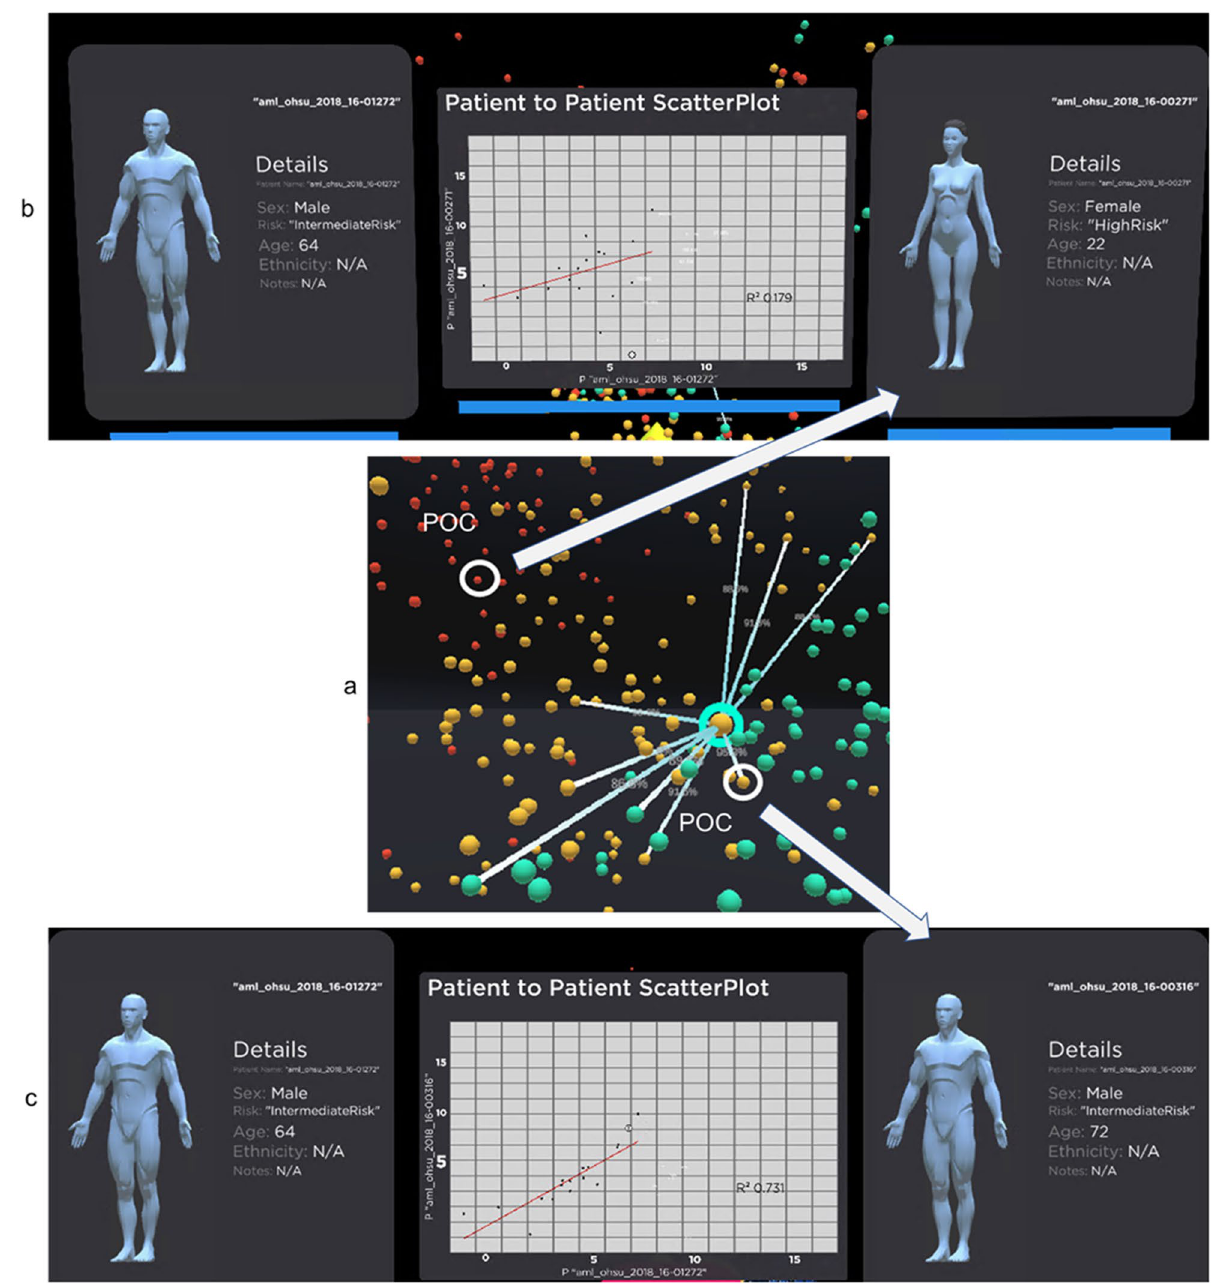
Figure 4. Patient-to-Patient Comparison panel. ( a ) The patient “aml_ohsu_2018_16-01272” is our POI, circled with green, while "aml_ohsu_2018_16-00271" and “aml_ohsu_2018_16-00316” are our POCs, circled with white. ( b ) POC—"aml_ohsu_2018_16-00271” is used to show the dissimilarity of the gene expression from POI. The scatter plot is used to analyse the similarity between the patient in term of their gene expression. These two patients have a similarity rate of 85%. When regression was carried out on the data, the model does not fit well, with only 0.179 R-square value. ( c ) In contrast, “aml_ohsu_2018_16-00316 ″ is very similar to POI at 91.5%. Regression model fit well with R-square value of